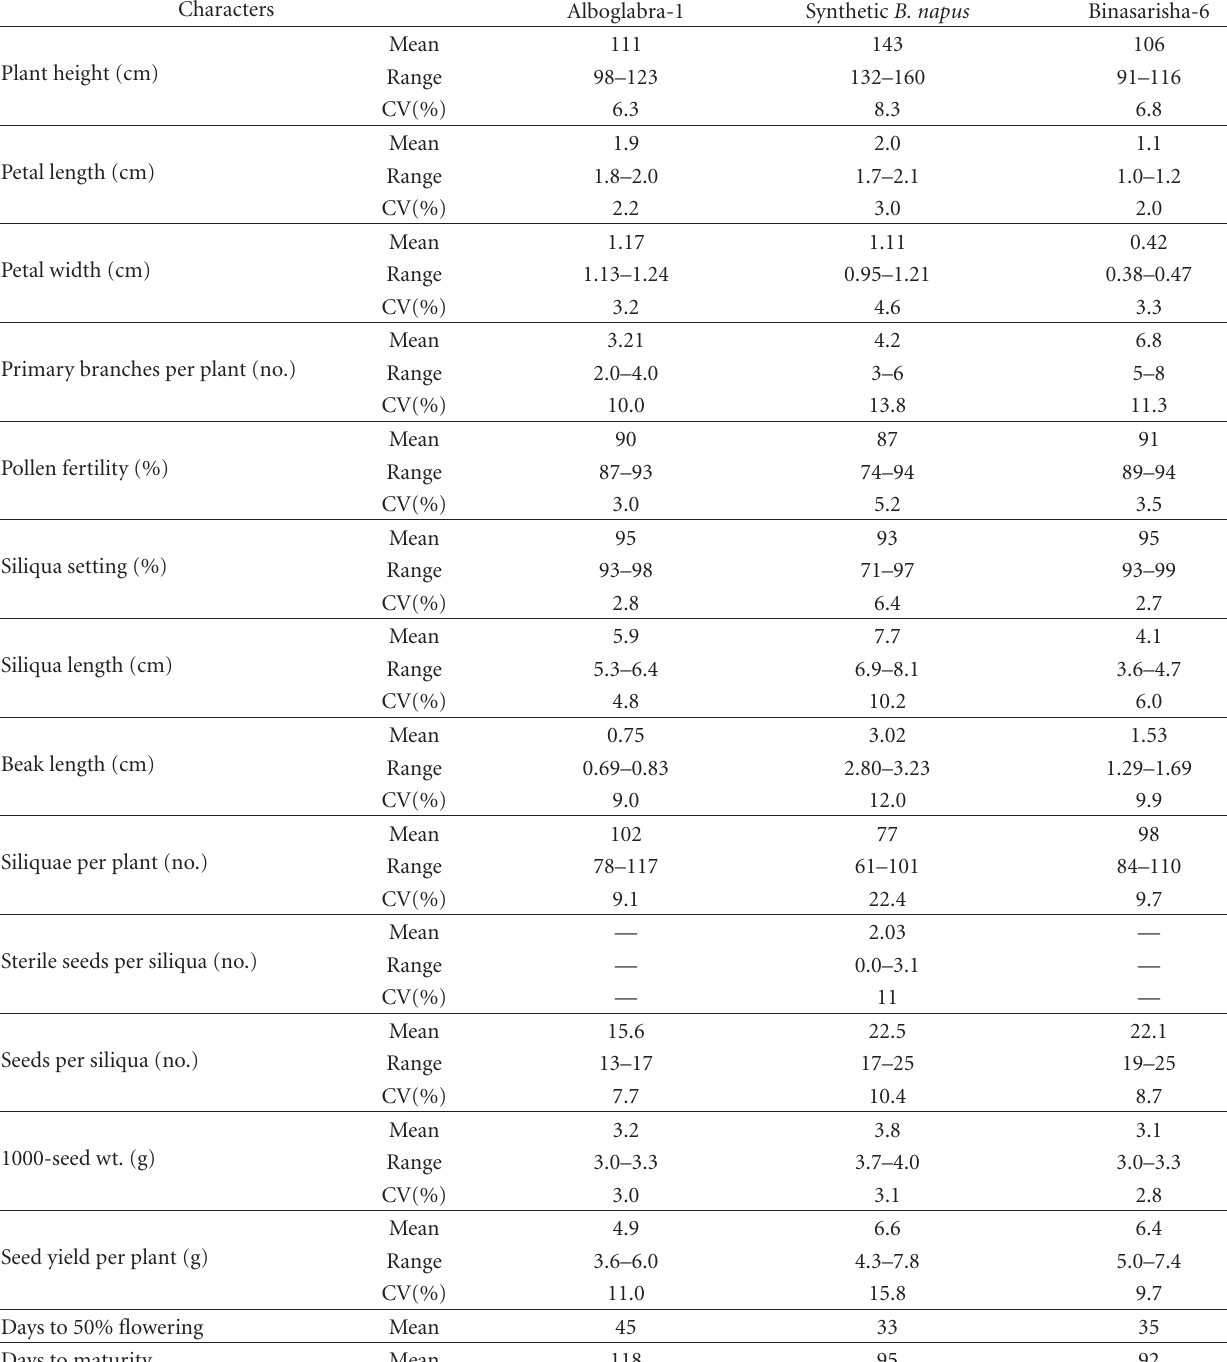
Table 1: Morphological characters, yield attributes, and seed yield of synthetic B. napus and its parental genotypes, Alboglabra-1, and